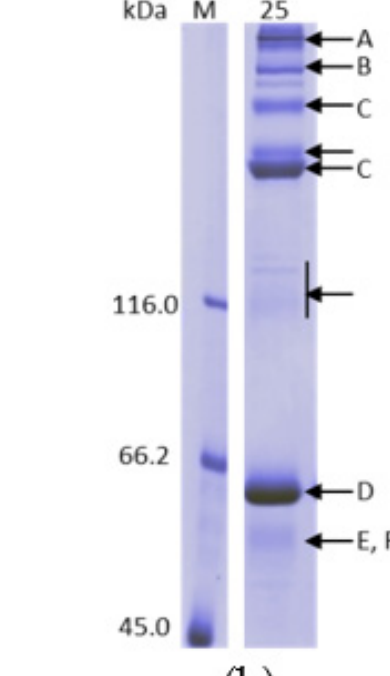
The spots analyzed are indicated by arrows in Figure 9a. The same four proteins were identified: Complement C4 binding protein, Fibrinogen, Complement C4 and Prothrombin (Table 3).